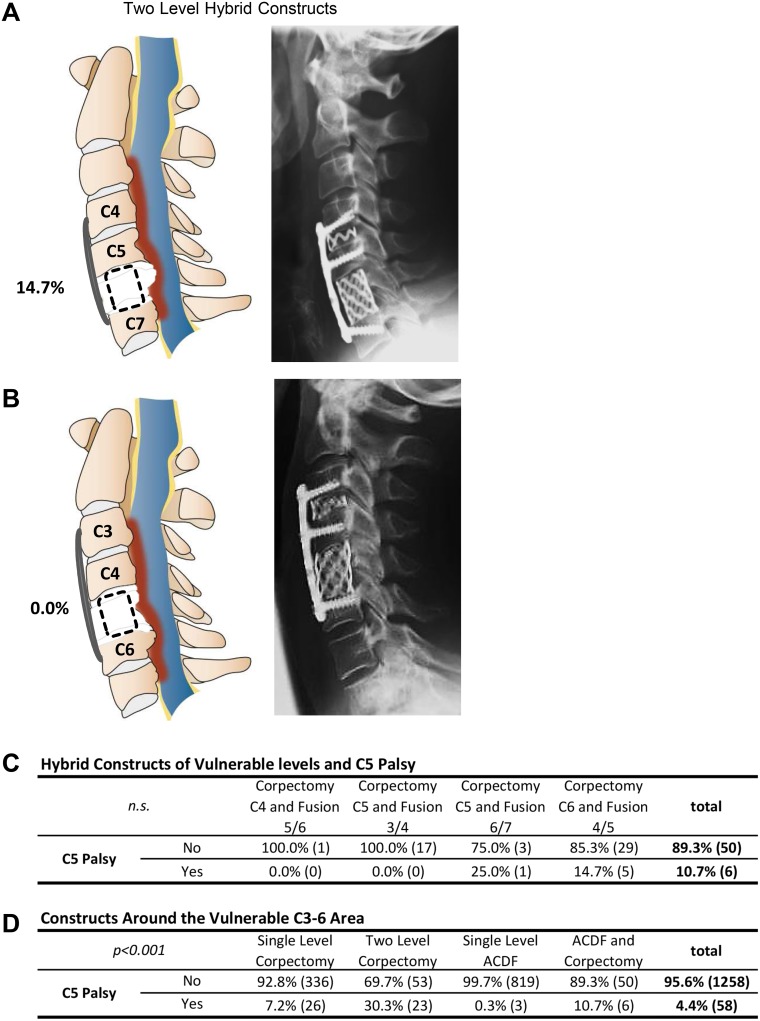
Sagittal schematic of the surgical spine to illustrate C5 palsy rate of two level hybrid constructs, i.e. combination of corpectomy and ACDF, for the levels C4-7 (A) and C3-6 (B). Statistical values are summarized in C, including overall C5 incidence rate for hybrid constructs on all levels around the vulnerable level of C4/C5. Additional information on other possible surgical constructs around the level of C4/C5 is presented in D, allowing for the direct comparison of C5 palsy rate of the different surgical strategies. Statistical analysis applied routine cross tables and chi2 testing.